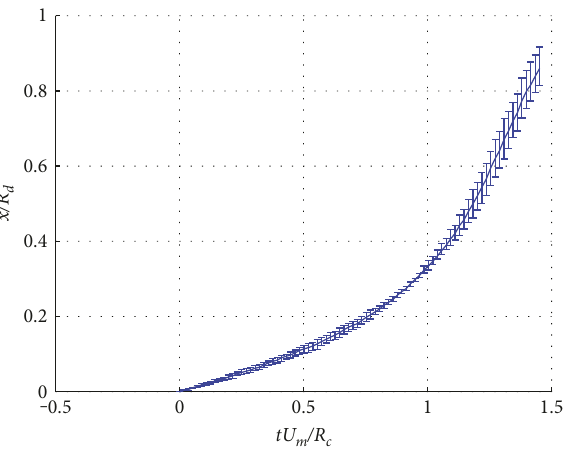
Figure 11: Experimental uncertainty associated to the di ff erent repetitions of case